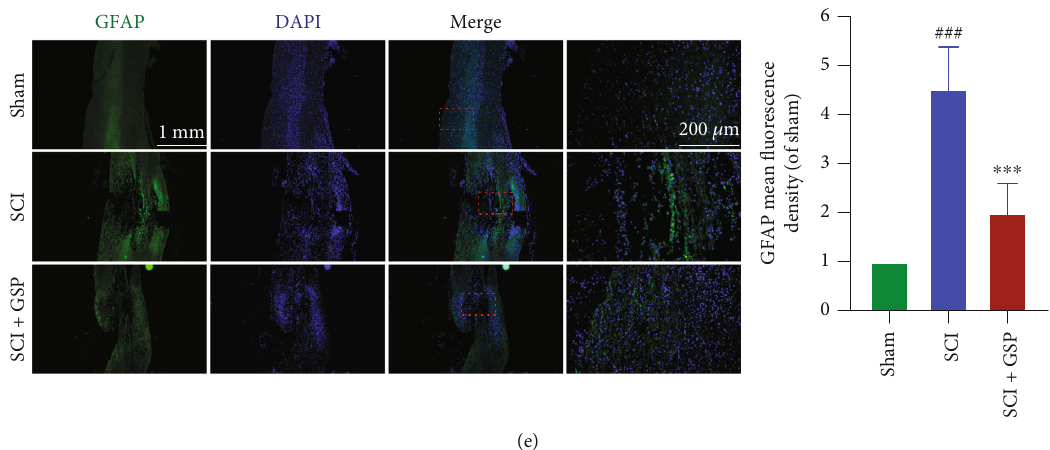
Figure 3: E ff ect of GSP on locomotor function recovery in SCI rats. (a) BBB score in the three groups at 28dpi ( n = 6 /group). (b) Footprints and their quanti fi cation analysis in each rat at 28dpi. Purple: frontpaw; Red: hindpaw ( n = 5 /group). (c) Representative HE staining images. ( n = 3 /group). (d) IF and quantitative data for NeuN (green) at 14dpi ( n = 3 /group). (e) IF and quantitative data for GFAP (green) at 14dpi. ( n = 3 /group). ## p < 0 : 01 , ### p < 0 : 001 vs. sham group, ∗∗ p < 0 : 01 , ∗∗∗ p < 0 : 001 vs. SCI